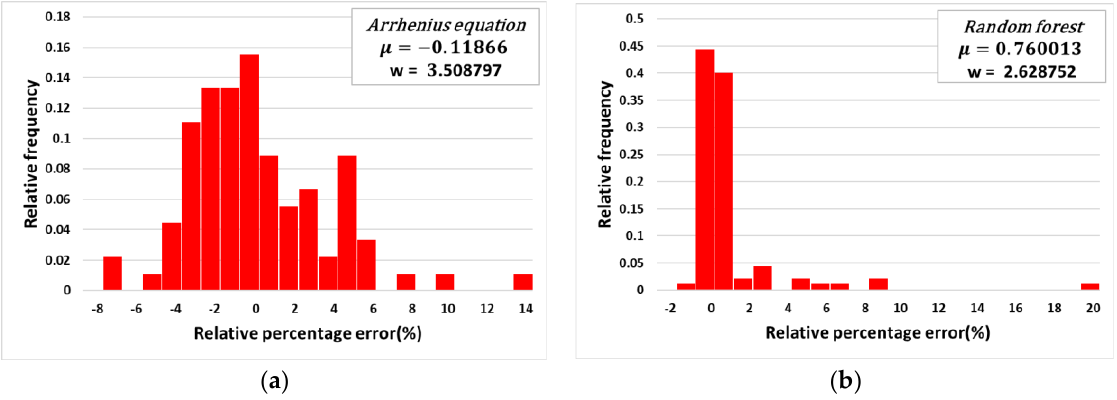
Figure 9. Plots of the relative percentage error by ( a ) the Arrhenius-type equation and ( b ) random forest algorithm.